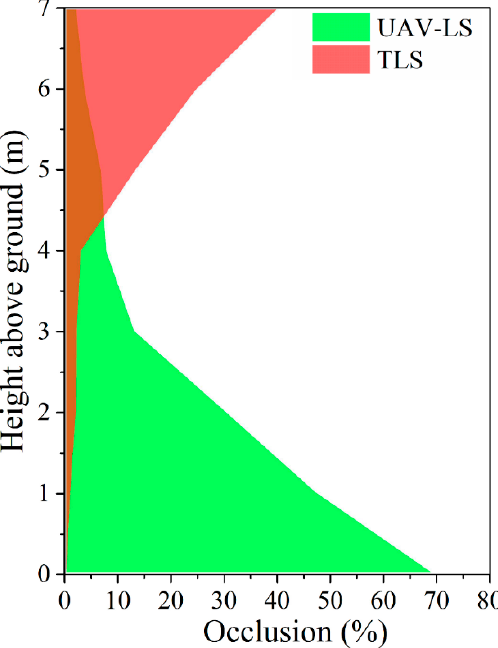
Figure 4. Vertical distribution of canopy occlusion based on the UAV-LS and TLS-based point cloud data. Occlusion is determined by comparing UAV-LS and TLS-based point cloud data against the fused point cloud.